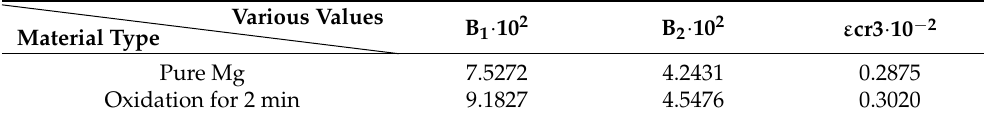
Figure 7. MgO/Mg composites material microplasticity curves: ( a ) all materials; ( b ) pure Mg; ( c ) oxidation for 2 min. Table 1. Critical strain and B value of MgO/Mg